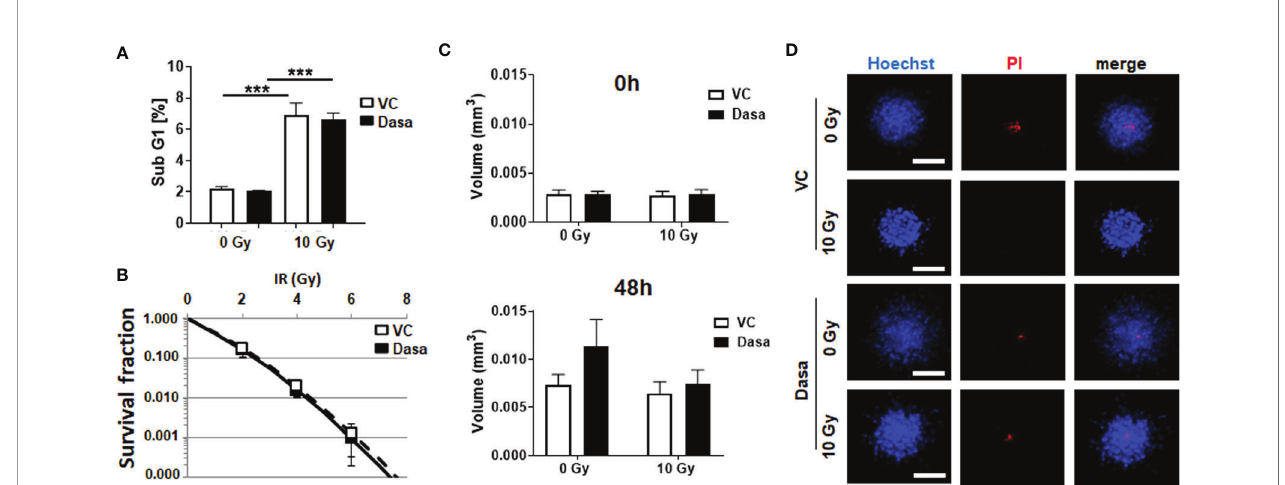
FIGURE 6 | Dasatinib treatment does not impact on survival or growth of stromal fi broblasts, nor in combination with RT. CAV1 expressing stromal fi broblasts (HS5) were cultured as monolayers (A, B) or spheroids (C, D) with or without radiation treatment (0 and 10 Gy) in the presence of dasatinib or vehicle control (VC), (A) Apoptotic cells (subG1) were analyzed 48 h post treatment by fl ow cytometry. Graphs consist of data from 3 individual experiments (with SEM). P-values indicate ***p ≤ 0.005 as estimated by one-way ANOVA with Tukey ’ s multiple comparison test. (B) Clonogenic survival was evaluated 10 days post treatment by counting respective colonies. Data show the surviving fractions from 3 independent experiments (means ± SD) plated in triplicates each. (C) Spheroid growth was measured and the respective volumes were calculated for 0 and 48 h after irradiation from 3 to 4 individual experiments where at least 10 spheroids per condition and per experiment each were measured. (D) Cell death was analyzed afterwards by fl uorescence microscopy using propidium iodide. Hoechst 33342 was used for nuclei staining. Representative fl uorescent images from individual experiments are shown (48 h time point). Scale bar represents 100